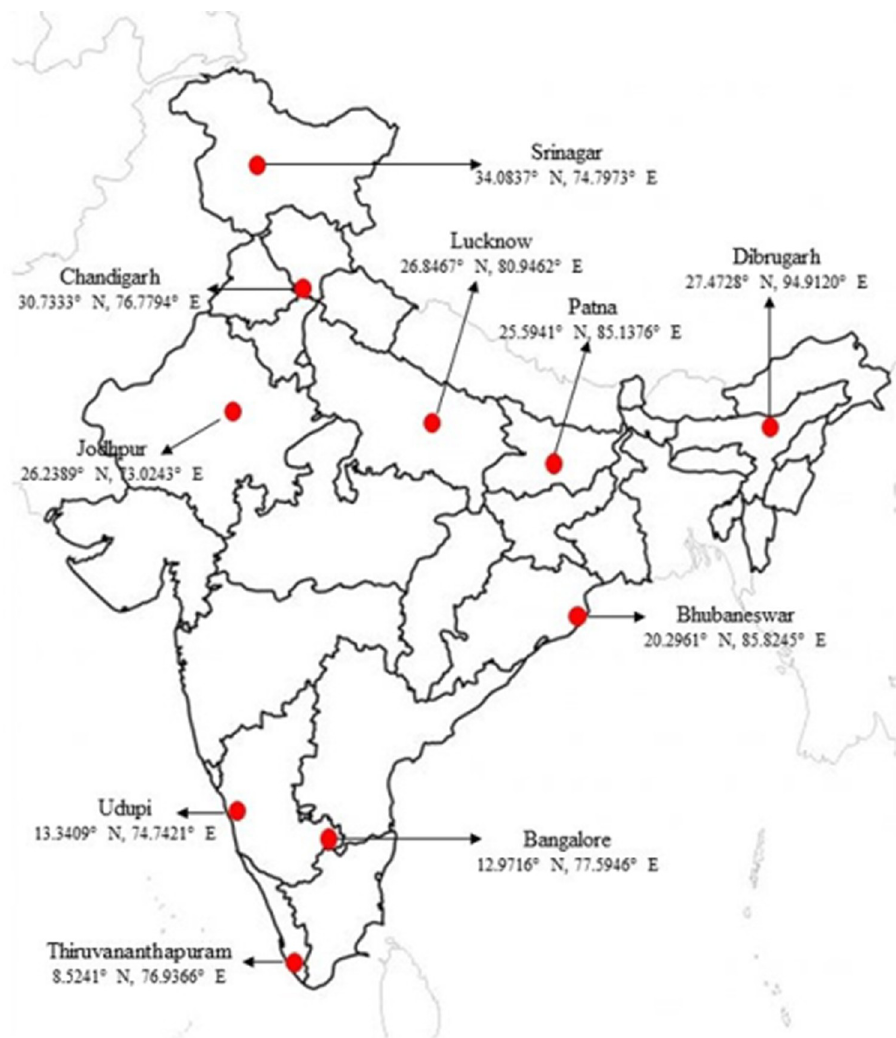
Fig 1. Study districts and their